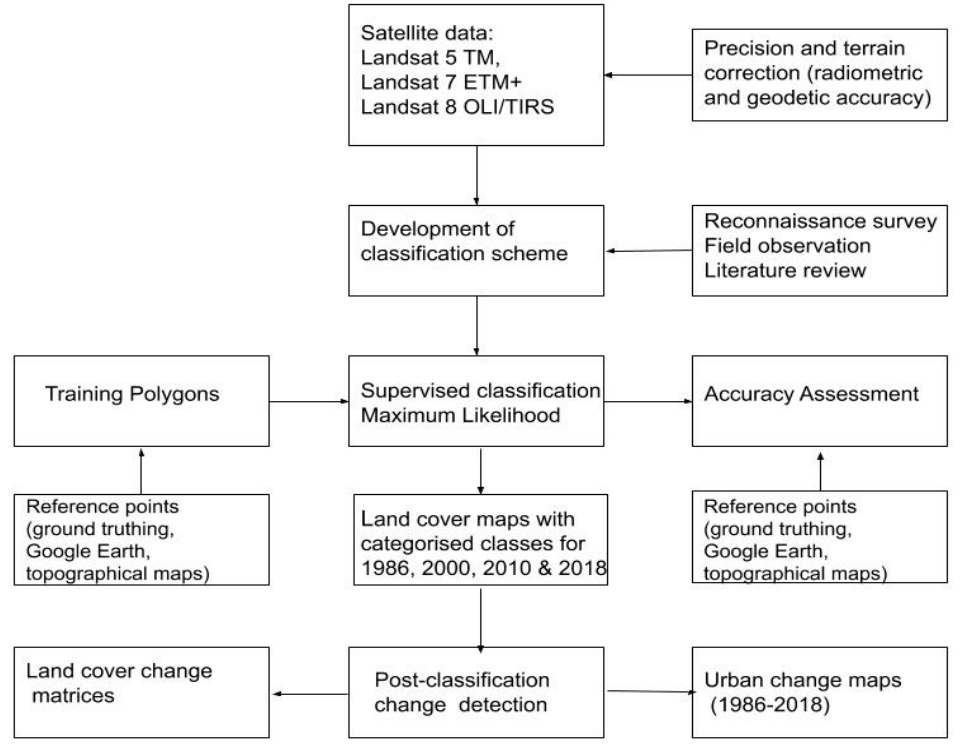
Figure 2. Workflow of land cover change analysis.